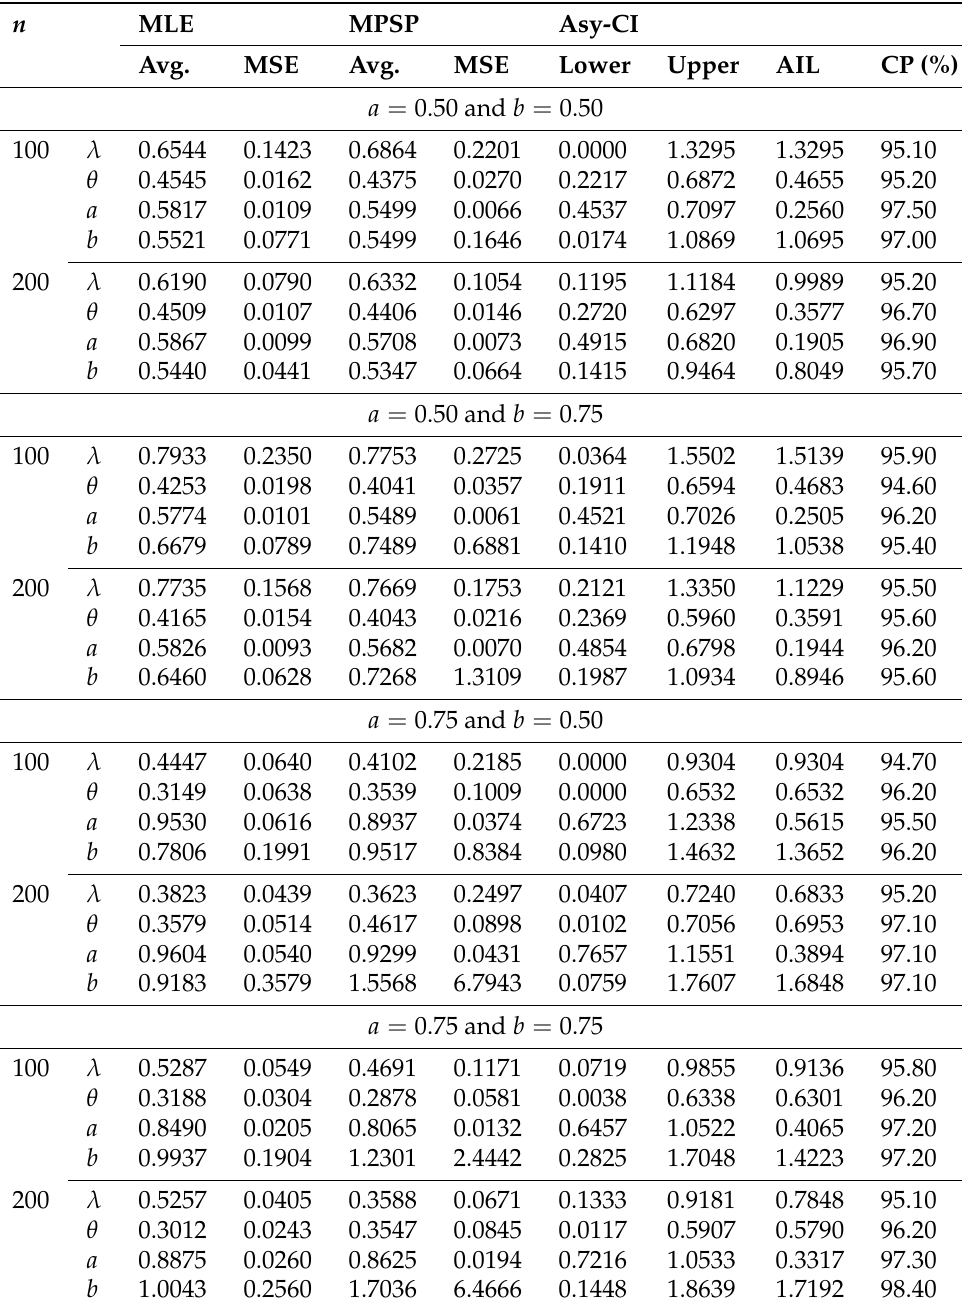
Table 6. Avg. estimated values, MSEs, Asy-CI, AILs and CP (in %) of Non-BE (MLE) for the MPSPr BBE 2 distribution at different sample sizes n and different values of ( a , b ) when λ = 0.50, θ =